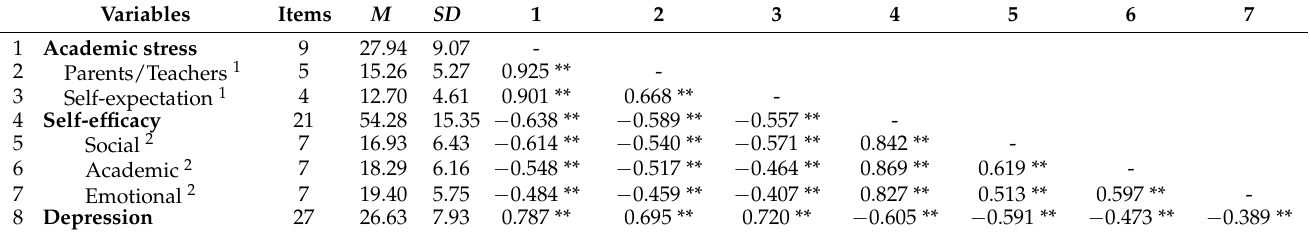
Table 1. Correlation matrix of research variables in the current study ( n =